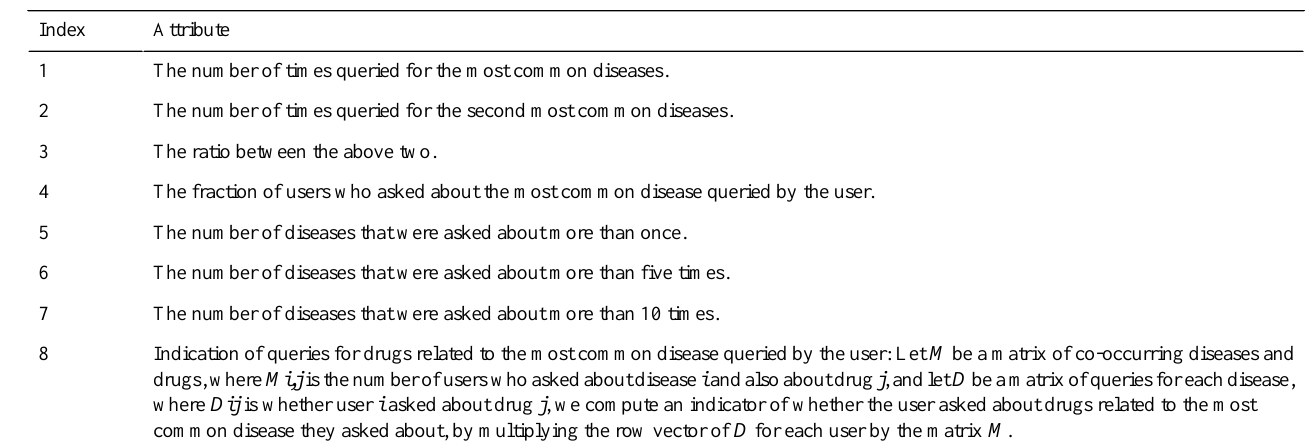
Table 4. Attributes used to predict whether the most frequently queried disease is the one afflicting the user. AttributeIndex The number of times queried for the most common diseases.1 The number of times queried for the second most common diseases.2 The ratio between the above two.3